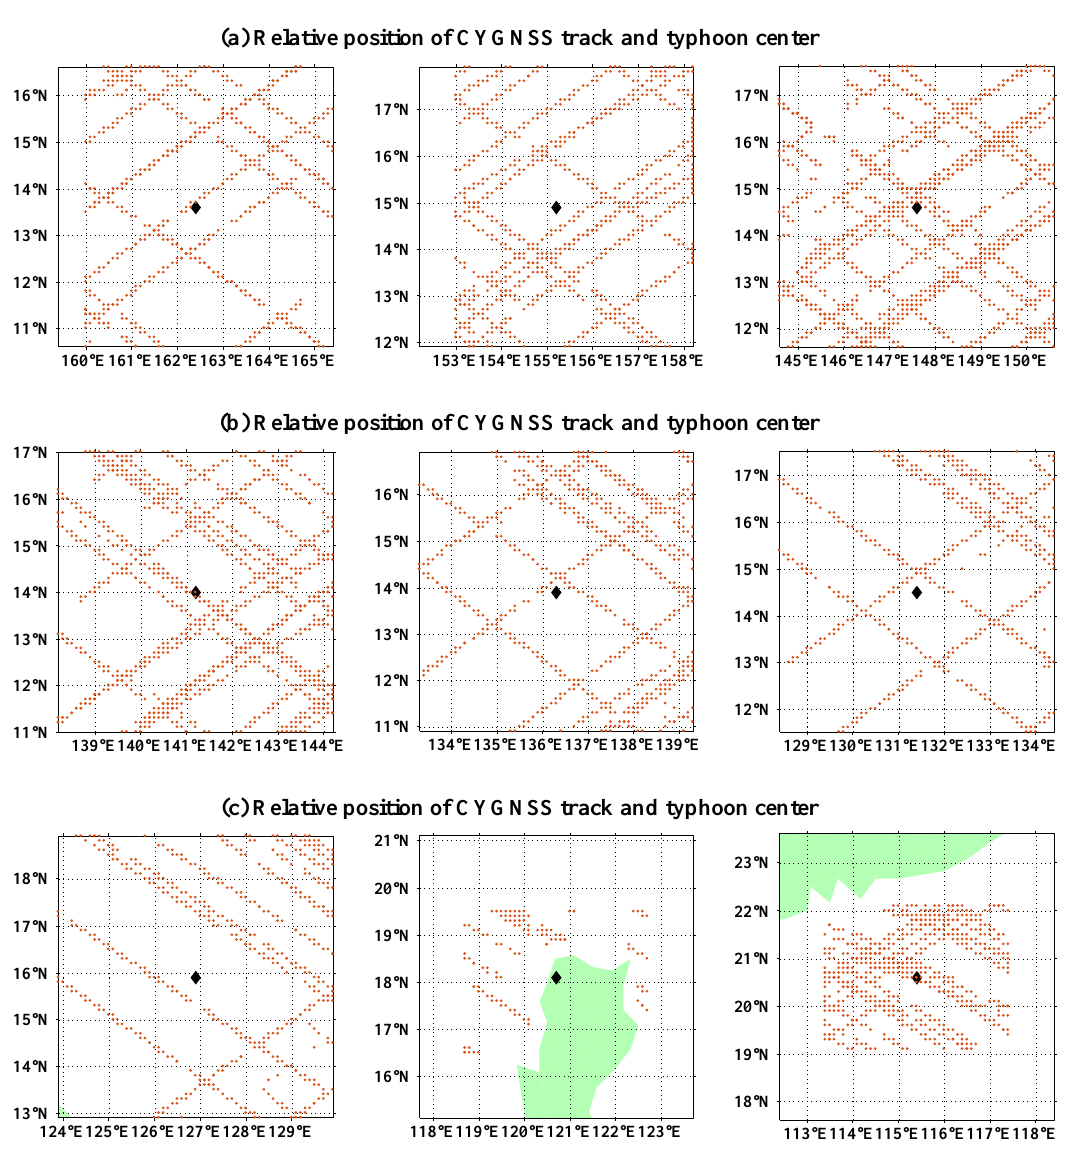
Figure 2. Specular point tracks and typhoon center position. The relative position of the CYGNSS track and the typhoon center from September 8th to September 16th. The orange line represents the CYGNSS track, the black dot represents the typhoon center and the green patch represents the Earth’s land. From September 8th to September 16th, at the same time of day, the collocated CYGNSS and ECMWF reanalysis data at the same latitude and longitude were enabled to be